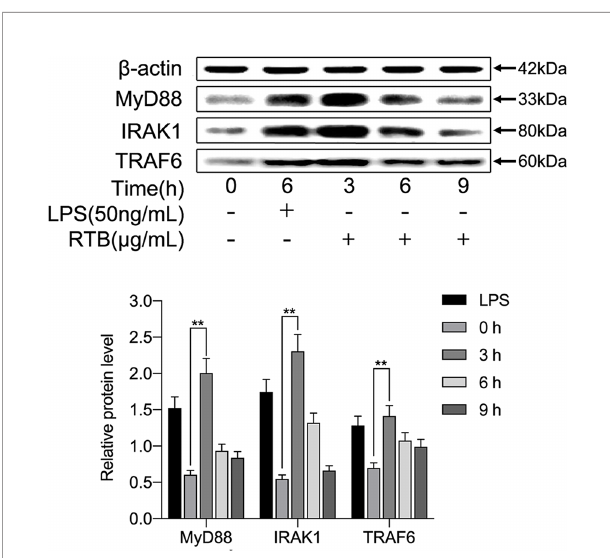
FIGURE 3 | Effect of RTB on the expression of TLR4-signaling pathway components in RAW264.7 cells. RAW264.7 cells were treated with RTB (50 m g/ mL) for 3, 6, or 9 h or LPS (50 ng/mL) for 6 h. Expression levels of MyD88, IRAK1, and TRAF6 were determined by western blotting. Relative protein level represents the relative expression of each protein versus actin. Representative results from one of three experiments with similar results are shown. Data represent the mean ± SD of three replicates. Signi fi cance was indicated as follows: p ≤ 0.01